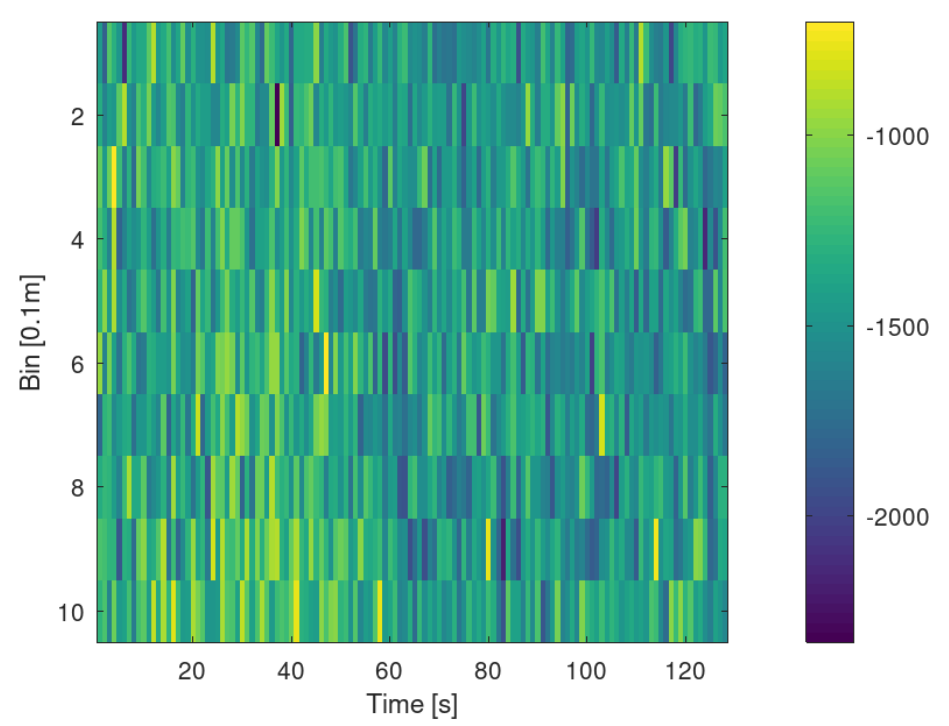
Figure A4. Waterfall plot of inflow x–velocity for Aquadopp 2 in mm/s. Bin size is 0.1 m.